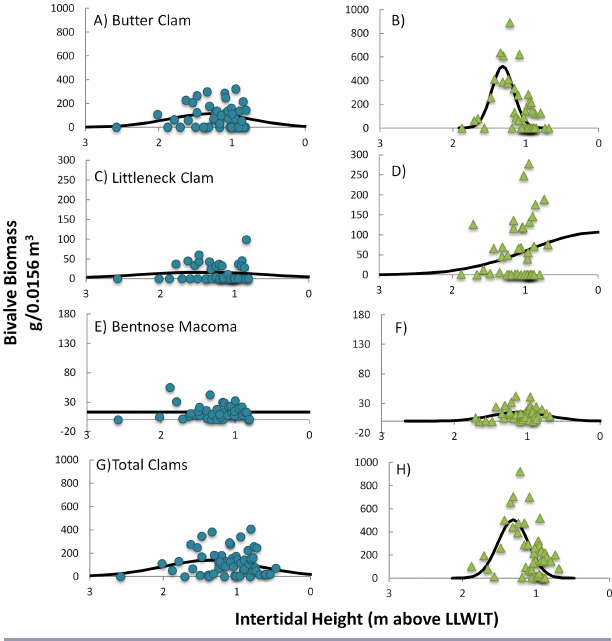
Fig. 7 . Actual (symbols) and predicted (line) biomass of (A and B) butter clams, (C and D) native littleneck clams, (E and F) macoma clams, and (G and H) total clams as a function of intertidal height (m above LLWLT) in nonwalled beaches (blue) and clam gardens (green). Note variation in y-axes range among different bivalve species. LLWLT = lowest low water large tide.